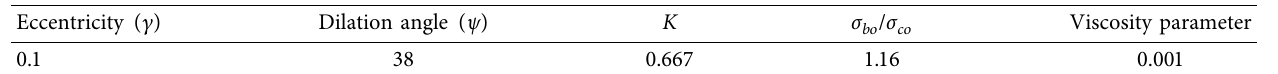
Figure 3: Concrete damage model inputs. (a) Compressive stress versus crushing strain. (b) Compressive damage versus crushing strain. (c) Tensile stress versus cracking strain. (d) Tensile damage versus cracking strain. Table 1: Concrete damage parameters.